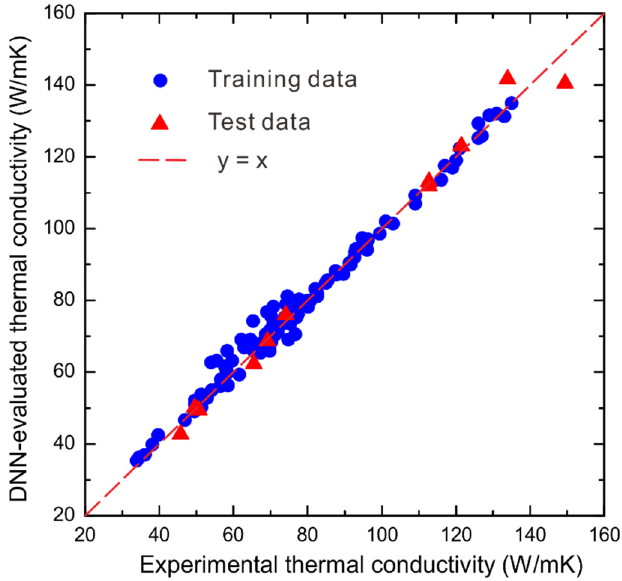
Figure 6. The comparison between the training and test thermal conductivities by fold 3 with measured thermal conductivities for the WC-Co system.